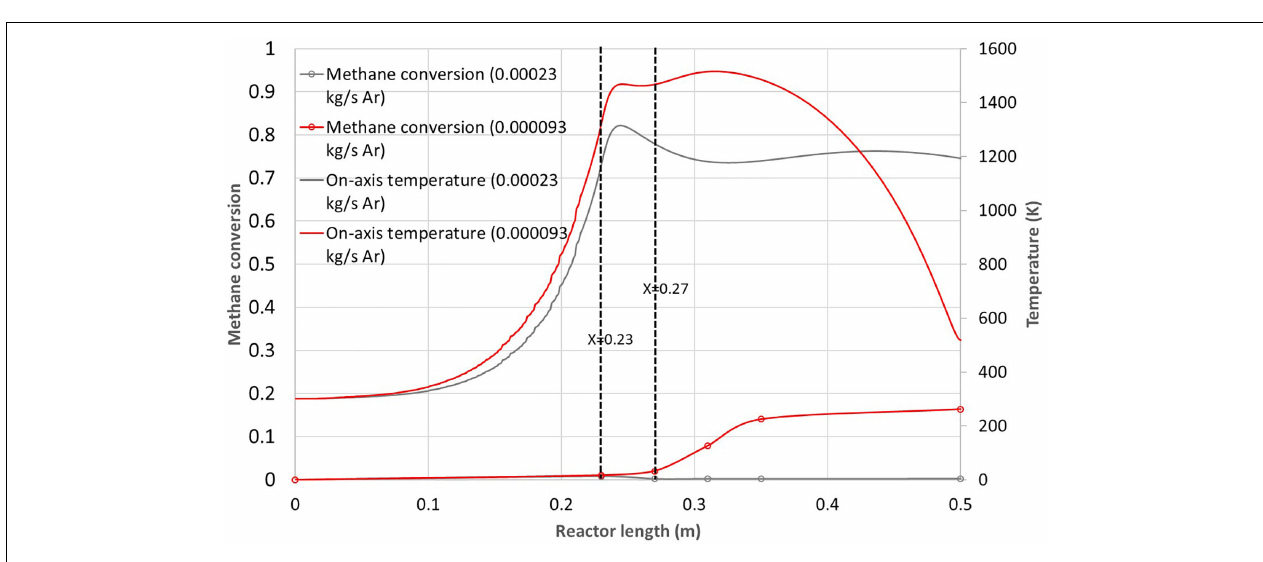
FIGURE 7 | On-axis methane mole fraction along with methane conversion vs. reactor length for the three reactor configurations.